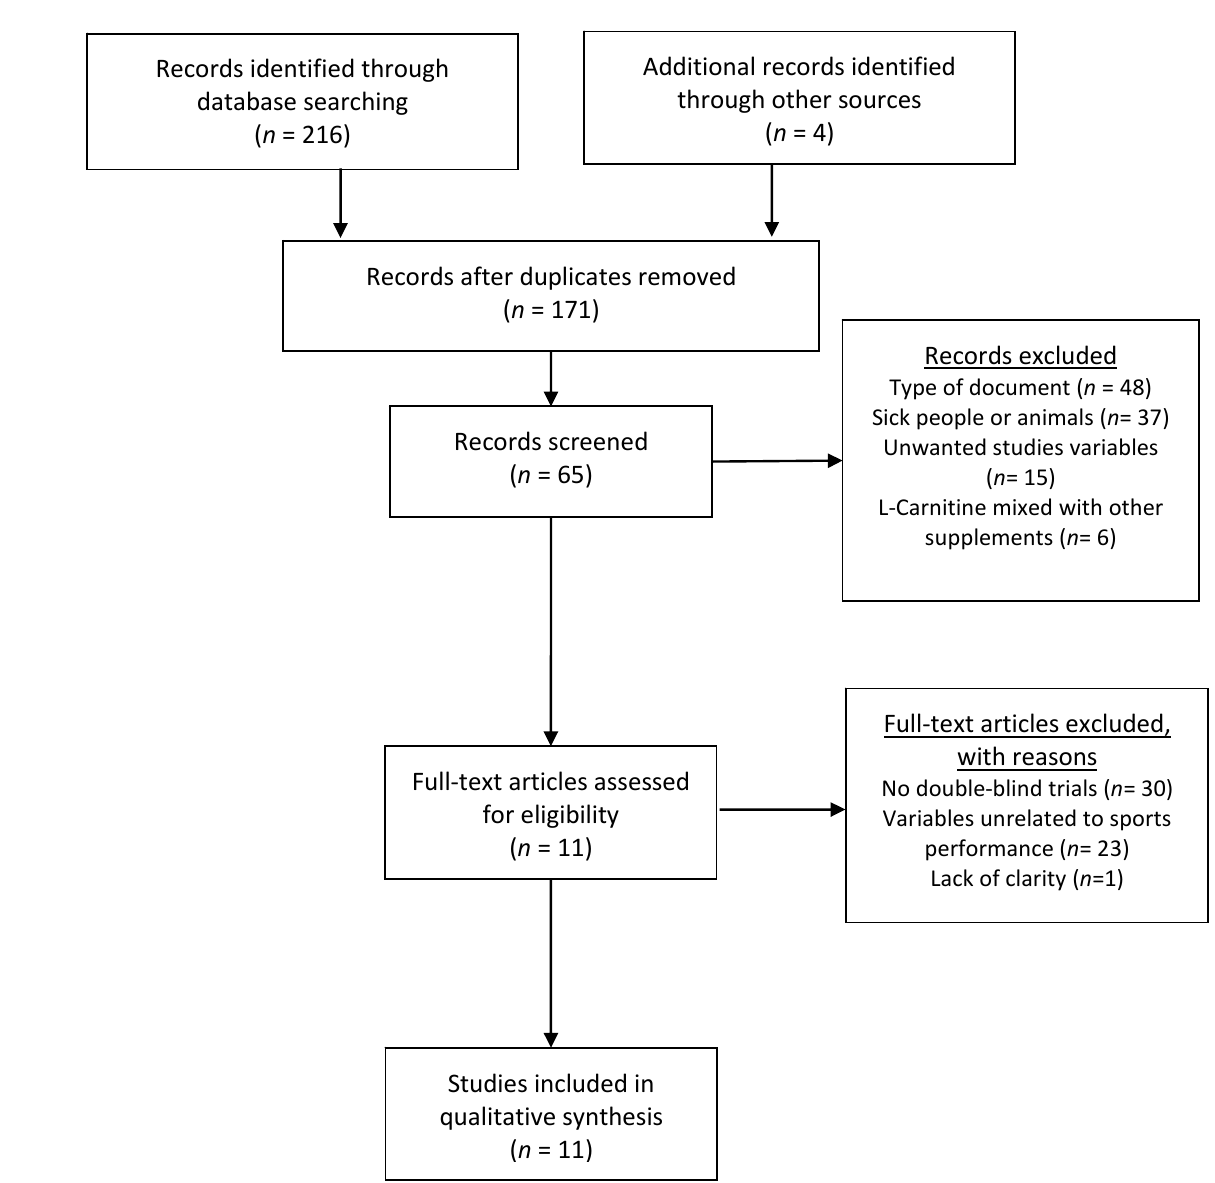
Figure 2. Selection of the studies included in the systematic review.